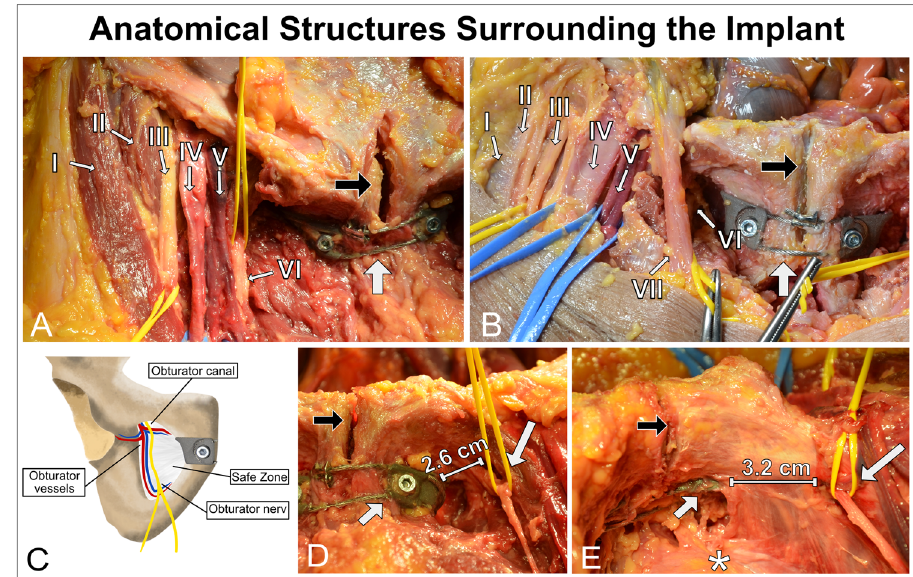
Fig. 8 Anatomical structures surrounding the implant. Cadaver study of the extrapelvic and intrapelvic area around the implant. A Anatomical structures of the muscular and vascular lacunae in a female cadaver. Identi fi ed are: (I) sartorius muscle, (II) iliopsoas muscle, (III) femoral nerve, (IV) femoral artery, (V) femoral vena, and (VI) obturator nerve. B Anatomical structures of the muscular and vascular lacunae in a male cadaver. Identi fi ed are: (I) sartorius muscle, (II) iliopsoas muscle, (III) femoral nerve, (IV) femoral artery, (V) femoral vena, (VI) obturator nerve, and (VII) spermatic cord. C Schematic illustration of the obturator foramen, showing the obturator canal where the obturator nerve and vessels pass out of the pelvis. The canal is located at the cranio-lateral border of the foramen, whereas the implant is on the opposite side. D Anterior view of the dissected obturator foramen. E Posterior oblique view of the obturator foramen covered by the fascia of the obturator internus muscle. An asterisk marks the bladder. Long white arrows indicate the obturator nerve exiting the canal. Short white arrows indicate the implant. Black arrows point to the pubis symphysis. The distance between the implant and the canal is also shown in panels ( D and E